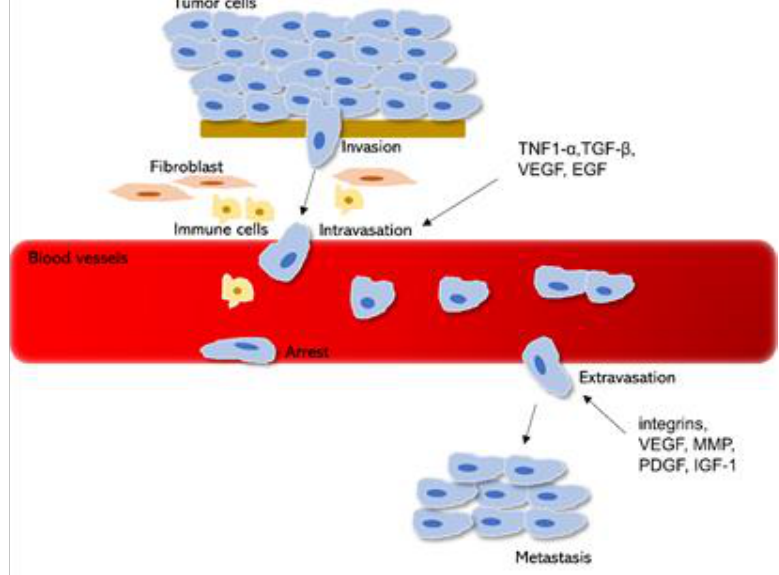
Figure 3. Overview of the metastasis process from primary tumor cells intravasate into the blood circulation followed by extravasation, supported by various growth factors, and settlement of the cancer cells at a distinct tissue site. Abbreviations: tumor necrosis factor 1α (TNF1-α); transforming growth factor- β (TGF-β),vascular endothelial growth factor (VEGF); epidermal growth factor (EGF); matrix metalloproteinase (MMP); platelet-derived growth factor (PDGF); insulin-like growth factor-1 (IGF-1).